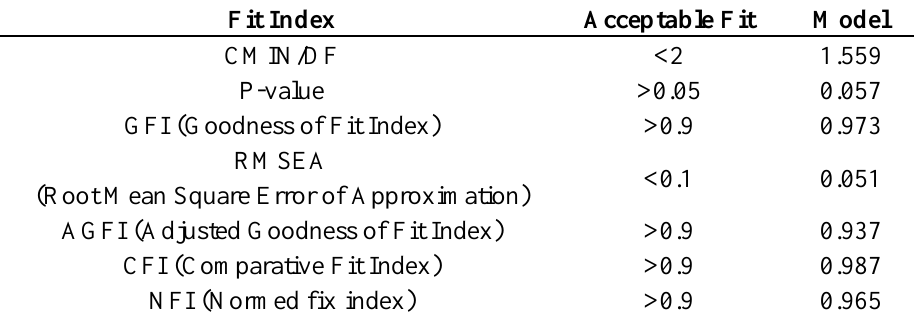
Table 10. Fit statistics for SEM